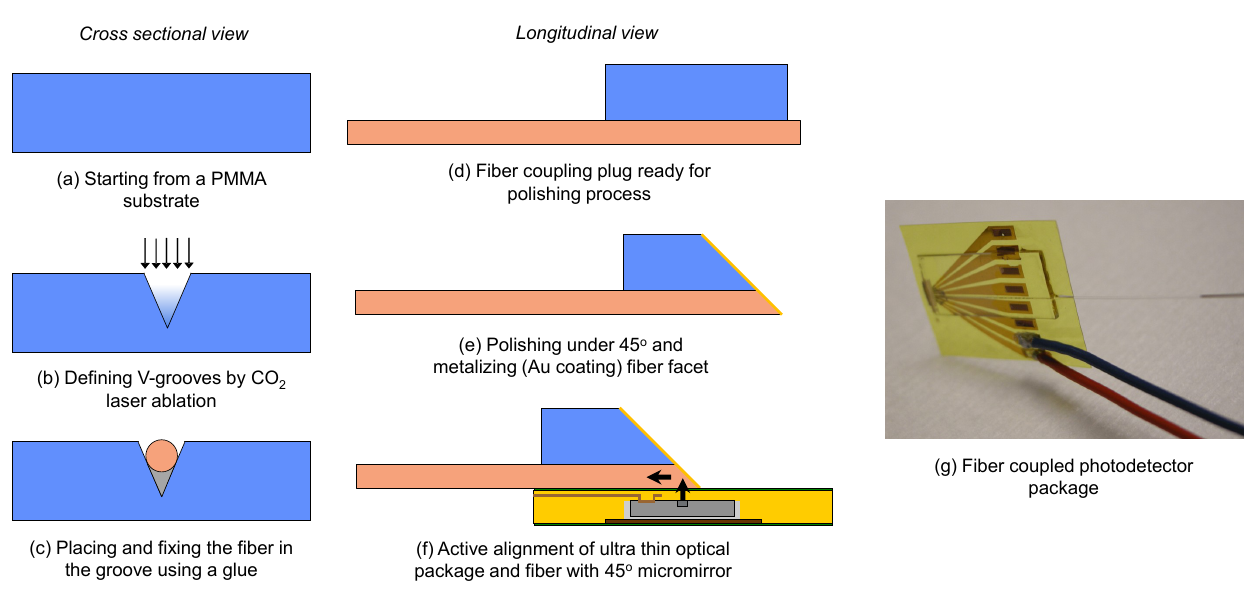
Figure 9. Integrated coupling process